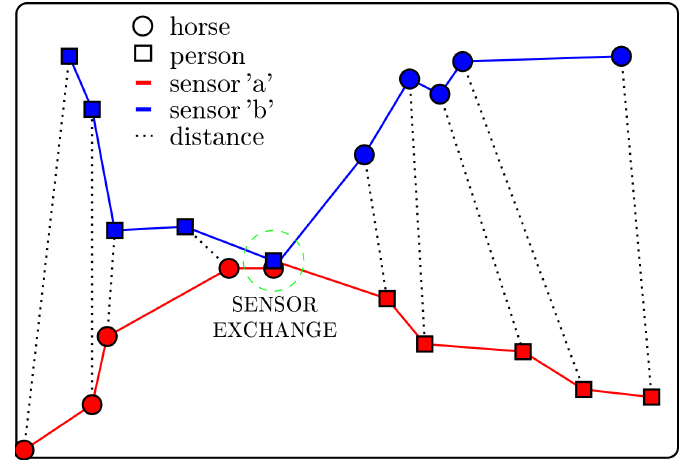
Figure 3. Graphical illustration of recorded GPS data during sensor exchange. The horse is marked by the circles, the person is marked by the rectangles. In the beginning the person is carrying the replacement sensor, i.e., sensor ‘b’ (blue rectangles) and the horse is carrying the sensor ‘a’ (red circles). Within the green dashed circle, the person has exchanged the sensors and is now carrying the replaced sensor ‘a’ (red rectangles). The horse is walking off with sensor ‘b’ (blue circles). For all positions marked with circles or rectangles GPS measurements can be found in the data set. The distances between paired GPS measurements are represented by dotted lines. Those distances reach a minimum with the sensor exchange and increase again